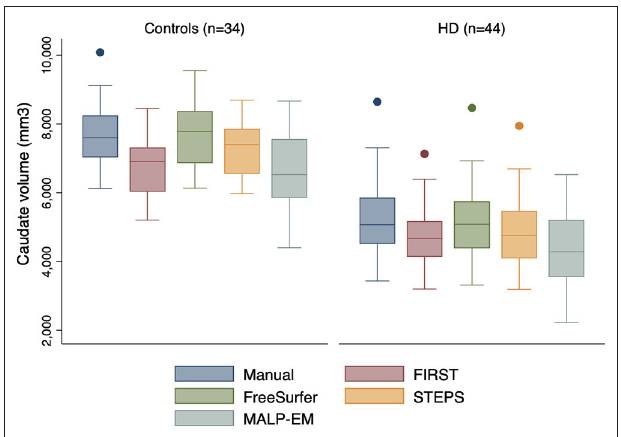
FIGURE 1 | Boxplots showing caudate volumes separated by group for each segmentation tool including manual segmentation. Boxes show first quartile, median and third quartile with whiskers representing the smallest and largest volumes. Dots represent outliers. Independent t -tests for each method demonstrated significant volume differences at 95% CI between the two groups, all p < 0.0001.